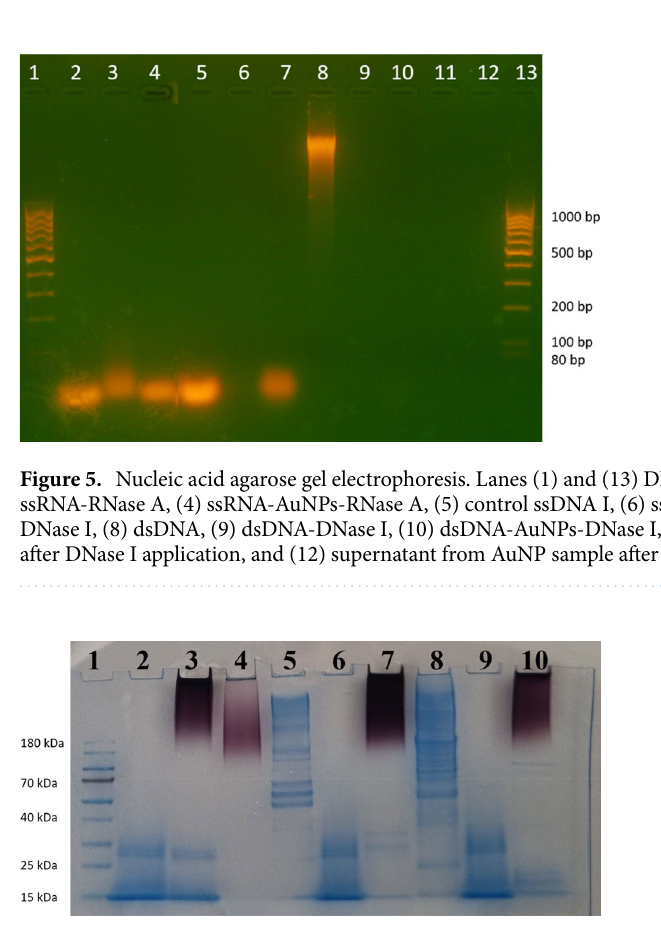
Figure 6. SDS-PAGE showing proteins digested with proteinase K and AuNPs-proteinase K. (1) Pre-stained protein ladder, (2) pure proteinase K, (3) unwashed AuNP-proteinase K, (4) washed AuNP-proteinase K, (5) fibrinogen as control, (6) fibrinogen with proteinase K, (7) fibrinogen with washed AuNP-proteinase K, (8) collagen type I as control, (9) collagen type I with proteinase K, (10) collagen type I with washed AuNP- proteinase